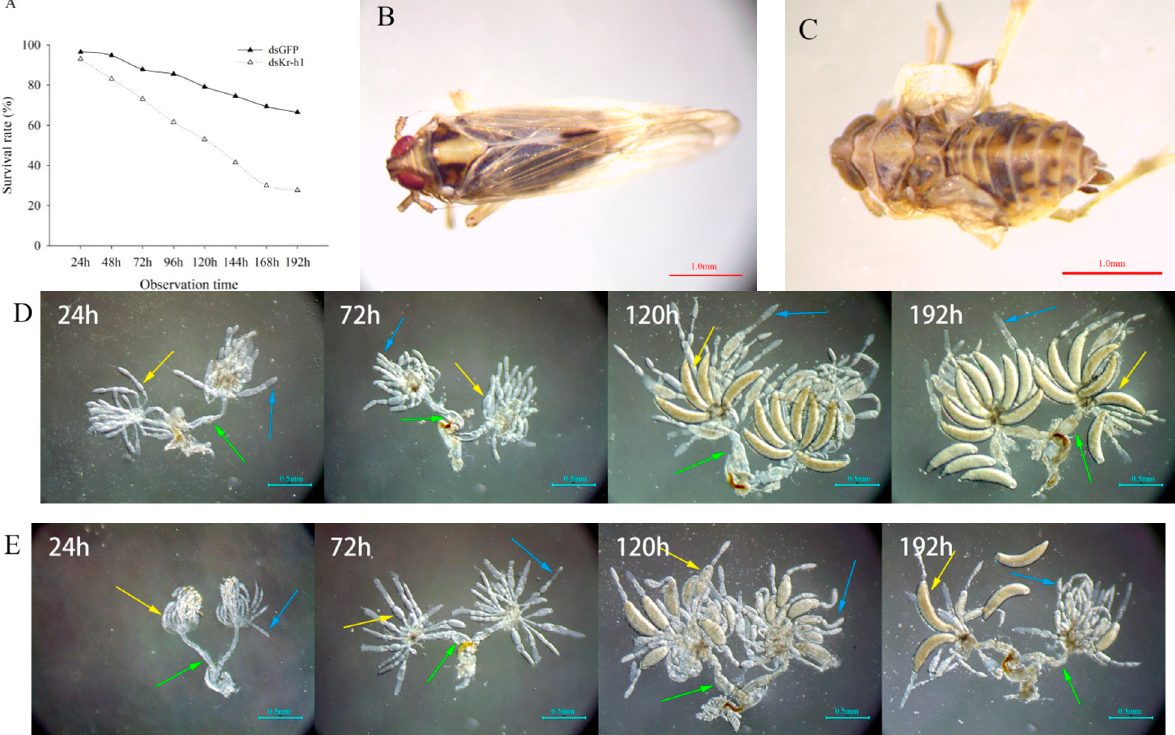
Figure 6. Phenotype of S. furcifera after RNAi. ( A ) Survival rate of S. furcifera . ( B , C ) Female adult development of S. furcifera after GFP-RNAi and Kr-h1-RNAi. ( D , E ) Ovarian phenotype of female adult S. furcifera after GFP-RNAi and Kr-h1-RNAi. Note: The time in the upper left corner represents the time of collection after adults. Blue arrows indicate the ovaries. Yellow arrow indicates the oocytes. Green arrow indicates the fallopian tubes.